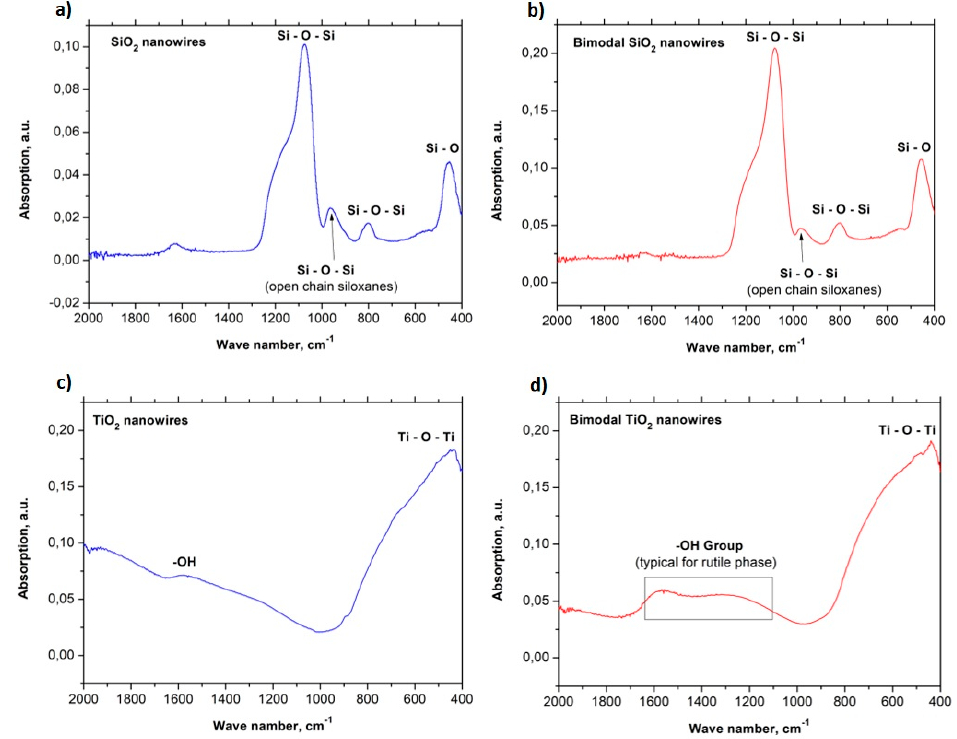
Figure 5. FTIR spectra for: ( a ) SiO 2 nanowires, ( b ) bimodal SiO 2 nanowires, ( c ) TiO 2 nanowires, ( d ) bimodal TiO 2